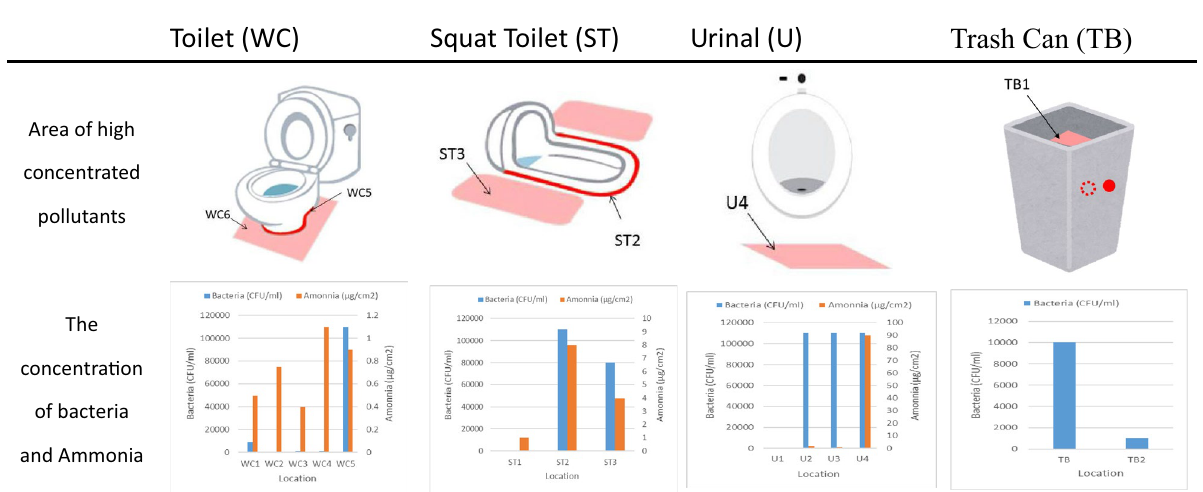
Table 2. Highly contaminated areas near